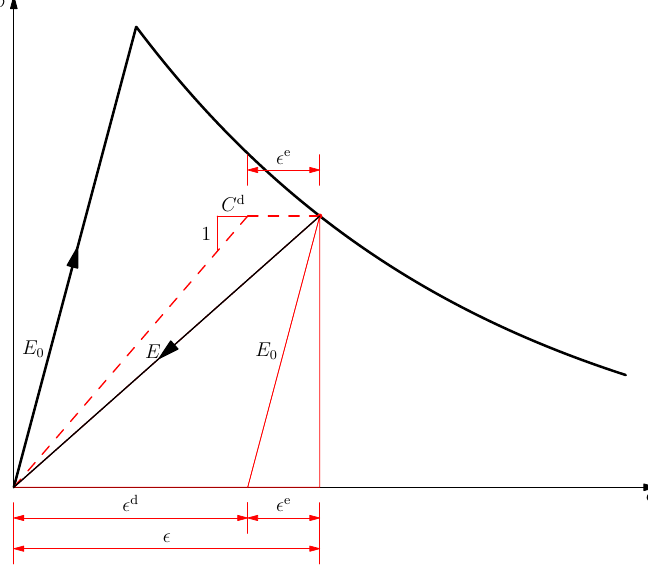
Figure 1. Elastic-damage model in the 1D